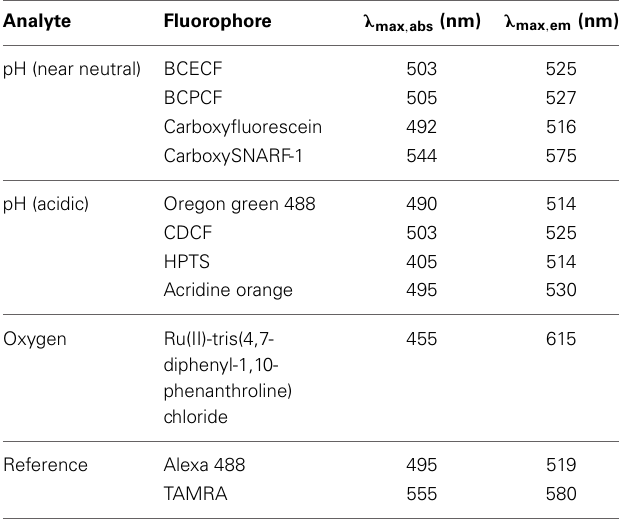
Table 1 | Selected commercially available indicator and reference